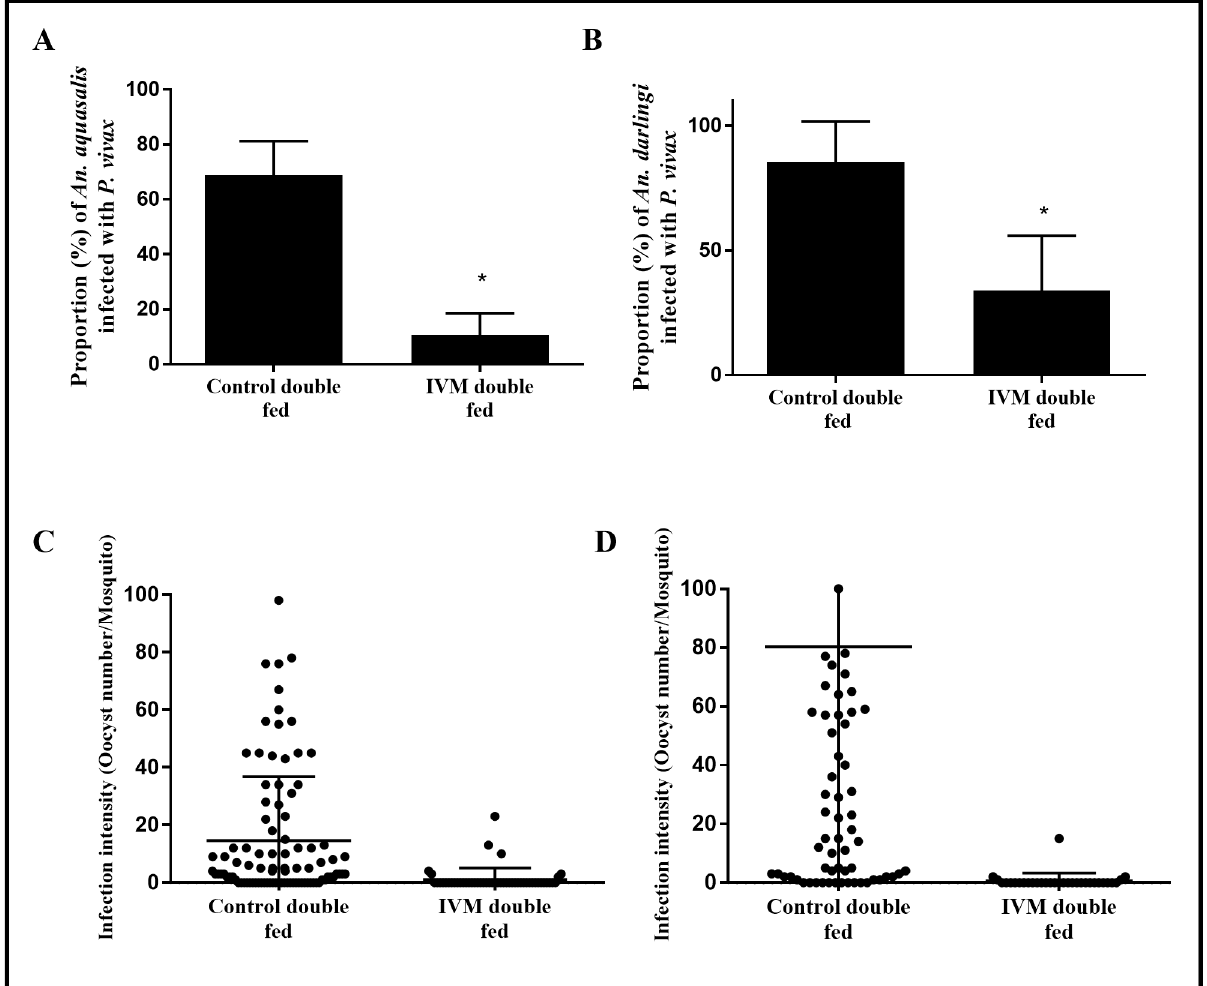
Fig 5. Ivermectin impairs Plasmodiumvivax development in Anopheles aquasalis and Anopheles darlingi when administered in a double feed 4 days after infection. An . aquasalis and An . darlingi female mosquitos were fed P . vivax blood samples. Four days after infection, two groups of mosquitos received a second uninfected blood meal with mIVM plasma from control (0 hours) or 4 hours after IVM intake. (A) The proportion of P . vivax infected An . aquasalis and (B) An . darlingi are presented as the mean and standard deviation. (C and D) The intensity of infection is presented as the number of oocysts per midgut (dots) and the black lines represent the median and standard error. Data from 5 independent experiments are presented. Asterisks ( (cid:3) ) represent significant difference (P < 0.05) in relation to